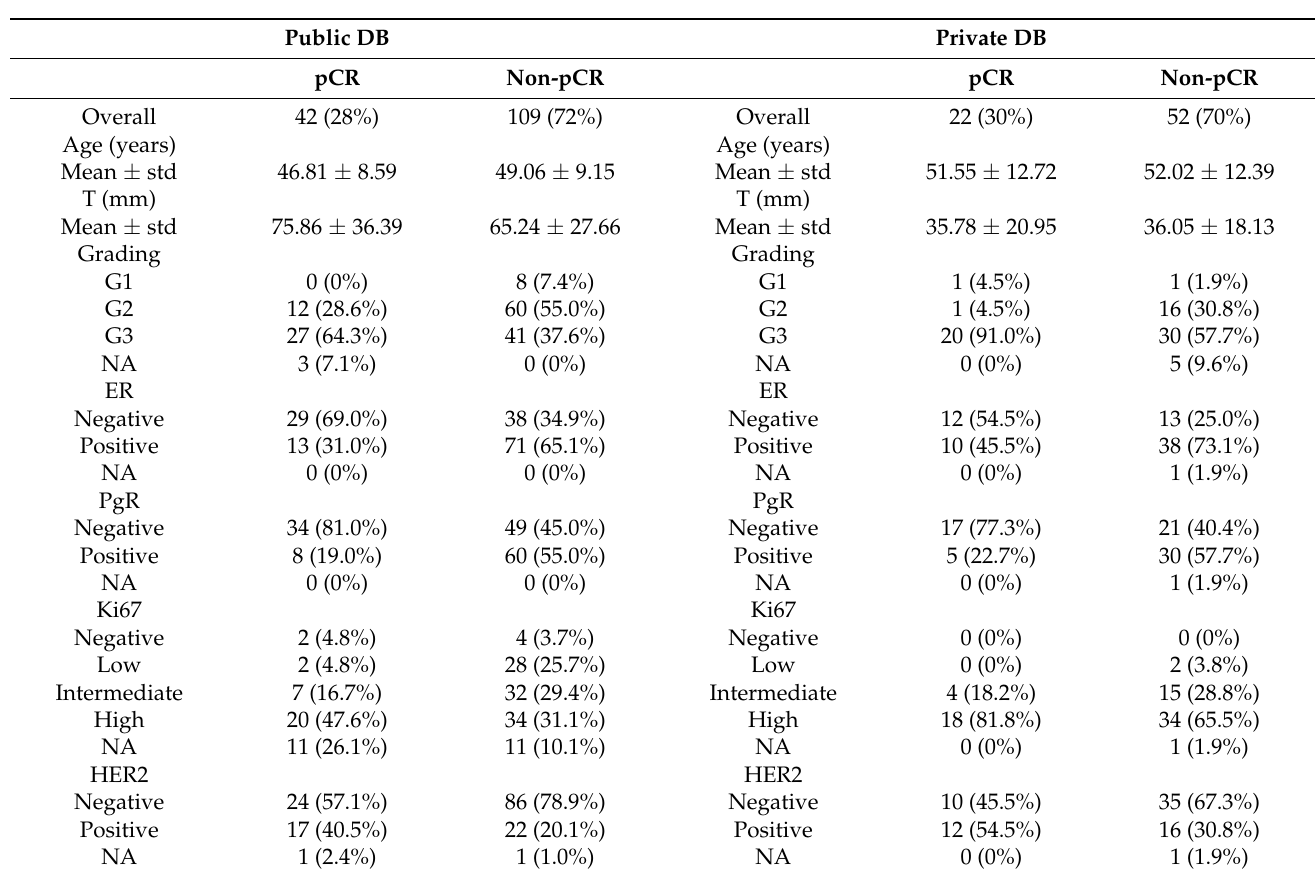
Table 1. Patient